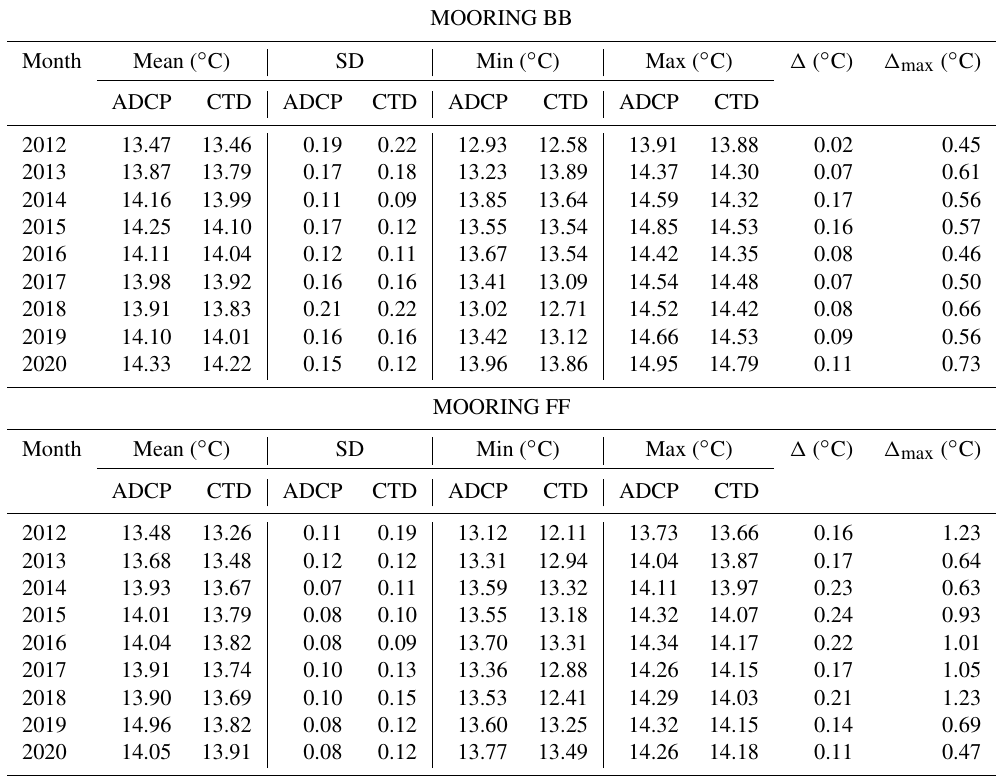
Table 5. Statistical parameters of temperature records of the two moorings grouped by years. SD indicates standard deviation and (cid:49) is the mean difference between temperature measured by ADCP and CTD and (cid:49) max is the maximum difference. The values reported in the table refer to original data (not